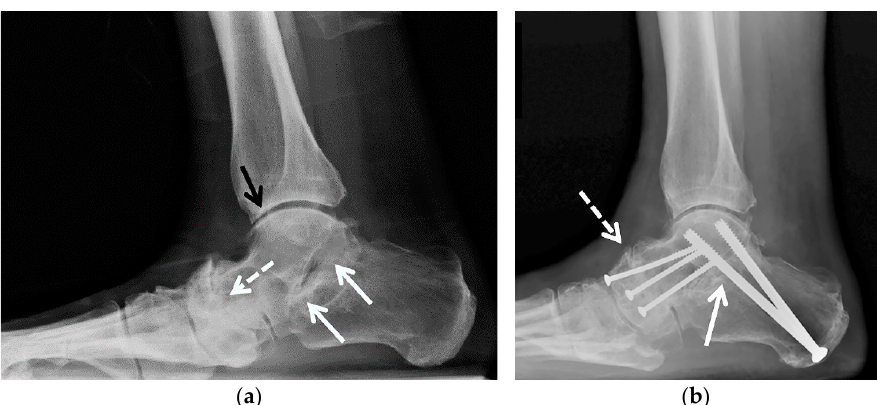
Figure 6. ( a , b ) A 72-year-old male with pes planus and severe talonavicular greater than subtalar osteoarthritis was treated with double hindfoot arthrodesis. ( a ) Preoperative weight-bearing lateral radiograph of the right foot shows severe osteoarthritis of the talonavicular (dashed white arrow) greater than subtalar joints (white arrows) and mild osteoarthritis of the tibiotalar joint (black arrow). ( b ) Weight-bearing lateral radiograph obtained 3 weeks after surgery shows three smaller partially threaded cannulated screws transfixing the talonavicular joint (dashed white arrow) and two larger, partially threaded cannulated screws transfixing the posterior subtalar joint (white arrow). Note the screws. The talonavicular and calcaneocuboid joints are fixated using a combination of significant improvement of hindfoot alignment. screws, staples, or plates [41].